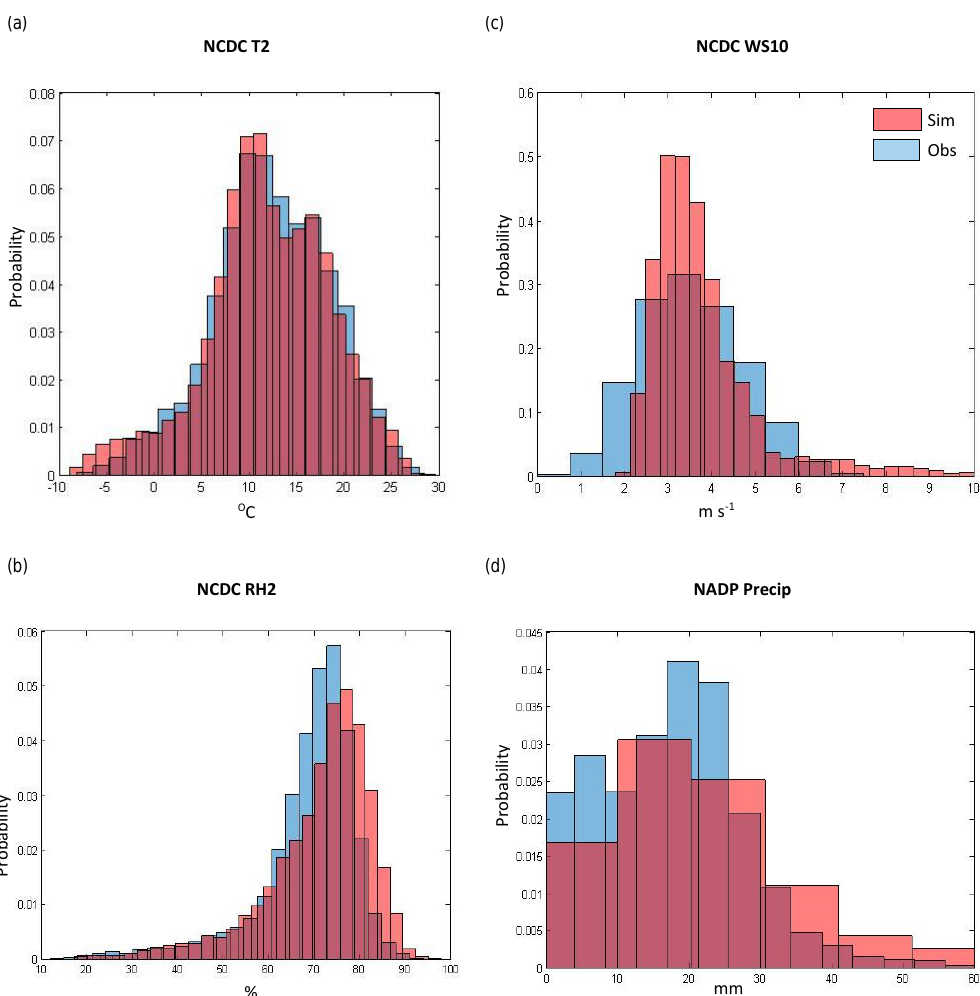
Figure 3. Probability distribution functions (PDFs) of (a) T2, (b) RH2, (c) WS10 against NCDC, and (d) precipitation against NADP for 2001 to 2010 over 30 bins in the respective ranges for all